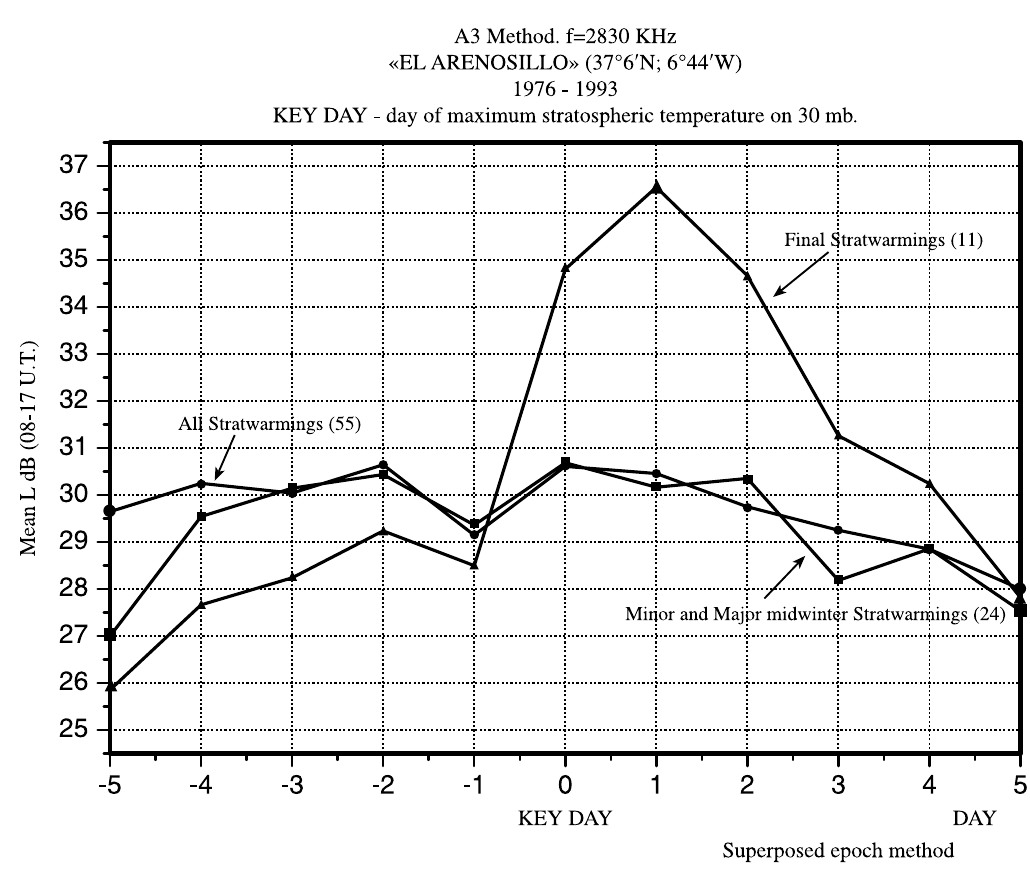
Fig. 5. Effect of stratospheric winter warming on daytime absorption of radio waves. A3 method. Transmitted frequency f = 2830 kHz, 1976-1993, El Arenosillo, Spain (37 ° 06 ′ N, 6 ° 44 ′ W). Key Day: day of maximum stratospheric temperature on 30 mbar level (de la Morena and Kazimirovsky,